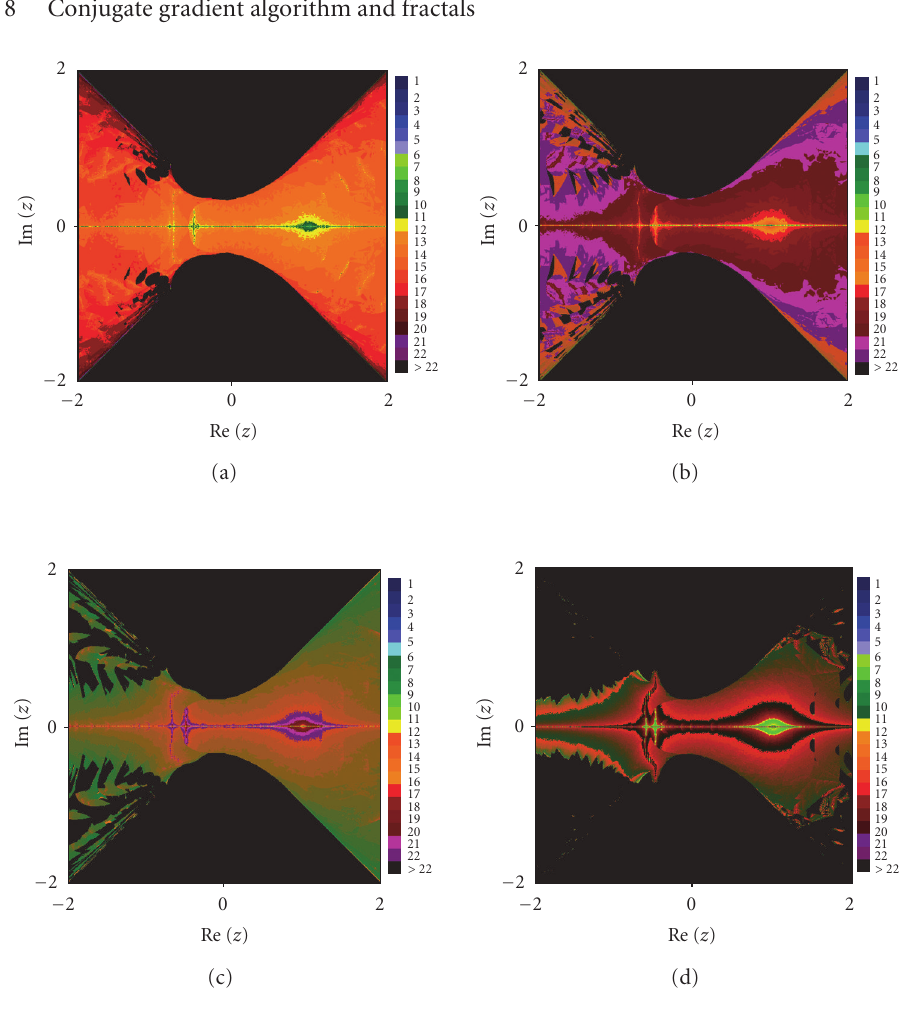
Figure 4.4. Basins of attraction of z 1 using (4.6) and W-L.S. with: (a) β = 0 . 1, (b) β = 0 . 2, (c) β = 0 . 3, (d) β = 0 .